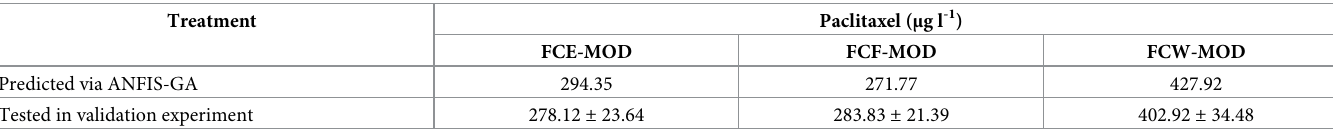
Table 3. Paclitaxel biosynthesis in Corylus avellana cell suspension culture (CSC) exposed to optimized fungal elicitor and methyl- β –cyclodextrin concentration levels, fungal elicitor adding day and CSC harvesting time in adaptive neuro-fuzzy inference system (ANFIS) models using genetic algorithm (GA), and predicted paclitaxel biosynthesis via ANFIS-GA.